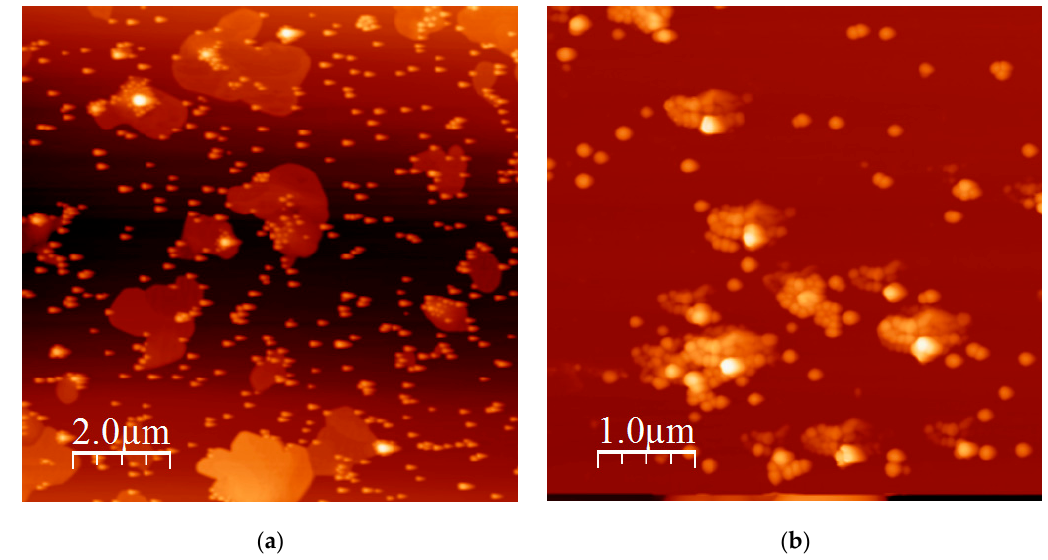
Figure 8. ( a ) Atomic force microscopy (AFM) height image of SH7.5/9/91 and ( b ) AFM height image of SH14/18/82.